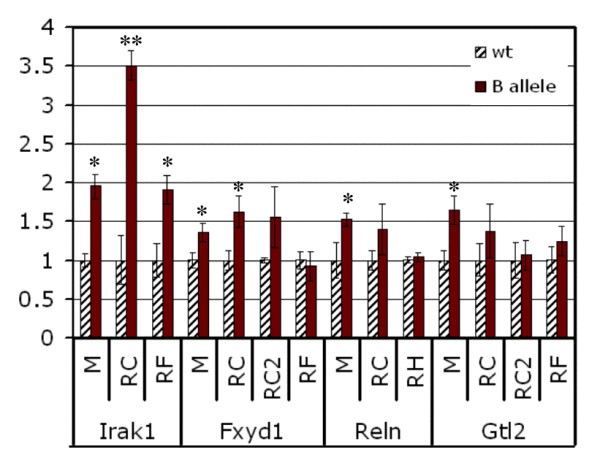
Microarray and qRT-PCR results for select DEGs. Irak1, Fxyd1, Reln and Gtl2 were selected for validation of expression changes by qRT-PCR analyses in B-allele mice. Cerebellum microarray expression data (M) are compared with qRT-PCR data from cerebellum (RC), forebrain (RF) and hippocampus (RH). For RC of Irak1, Fxyd1 and Gtl2, the 8 wk samples from the microarray analysis were used. RC2 data are derived from an independent set of litters at 7.5 to 8 wk. Error bars represent SEM. One asterisk indicates P < 0.05, two asterisks indicate P < 0.001. Irak1 expression was markedly increased in the cerebellum of 8 wk B-allele mice on microarray (2-fold, P = 0.011, four mutant/wild-type pairs) and qRT-PCR (3.5 fold, P < 0.001, four mutant/wild-type pairs) as well as in the forebrain of a different set of mice at 7.5 wk (1.9 fold, P < 0.05, three mutant/five wild-type). Fxyd1 expression was elevated 1.4-fold on microarrays (P < 0.05, five mutant/wild-type sibs) and qRT-PCR (RC) (P = 0.053, four mutant/wild-type sibs). The RC2 data (five mutant/three wild-type) were more variable and yielded P = 0.16. Reln displayed an ~ 1.5 fold increase in expression on microarrays (P = 0.03, four mutant/wild-type pairs) and qRT-PCR (P = 0.06, five mutant/wild-type pairs) at 2 wk (RC) and was not changed in hippocampus (RH). On microarray, Gtl2 expression was increased at 8 wk, but by qRT-PCR we found highly variable Gtl2 expression in cerebellum (RC and RC2). Gtl2 expression was not significantly increased (P = 0.29, eight mutant/eight wild-type) in the forebrain.